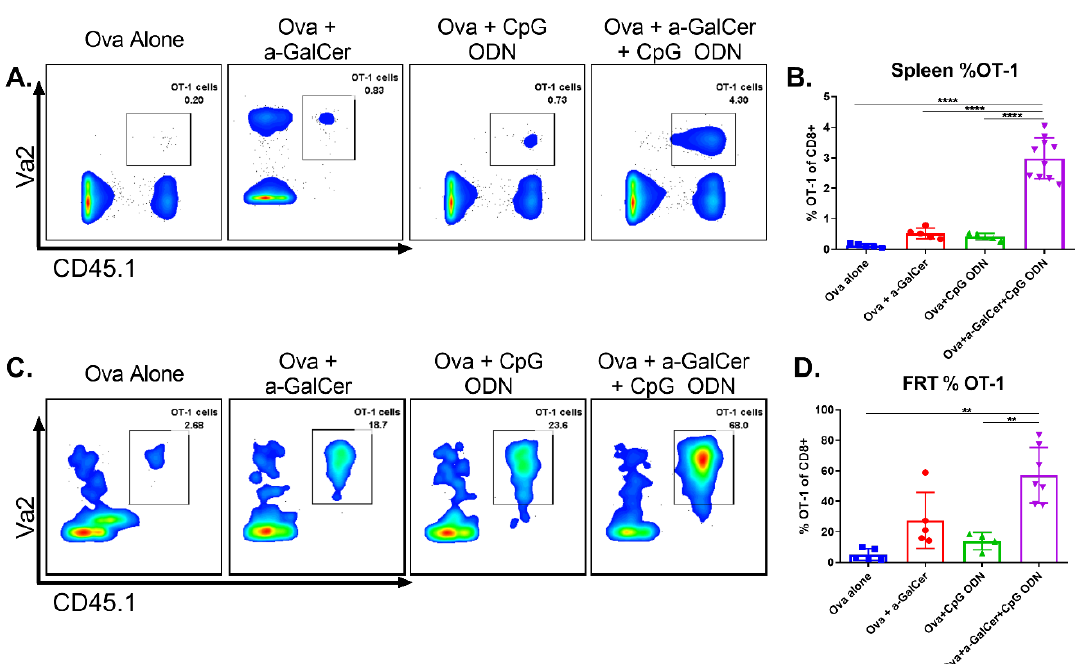
Figure 4. Intranasal vaccination using α -GalCer and CpG-ODN adjuvants a ff ords significant increase of antigen-specific CD8 T cells to the female reproductive tract (FRT). Adoptively transferred OT-I cells were analyzed by flow cytometry in spleen and FRT one week after intranasal ovalbumin immunization using α -GalCer and CpG-ODN adjuvants individually or together. Representative dot plots for spleen ( A ) and FRT ( C ) along with cumulative data from multiple mice in two independent experiments are shown ( B , D ). Statistical significance was calculated using ordinary one-way ANOVA with multiple comparisons (B) and the Brown–Forsythe and Welch ANOVA with multiple comparisons (D), p < 0.005 (**), p < 0.00005 (****).